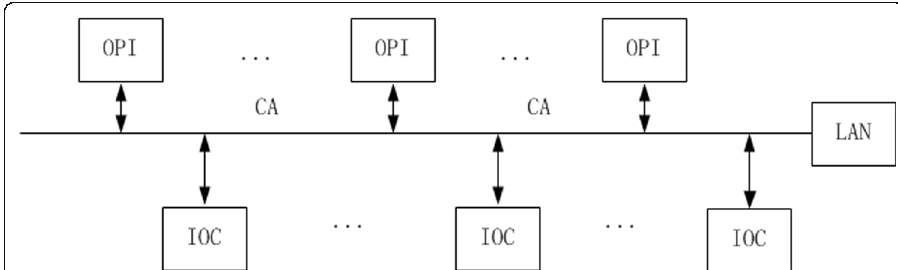
Fig. 7 The Software Structure of EPICS